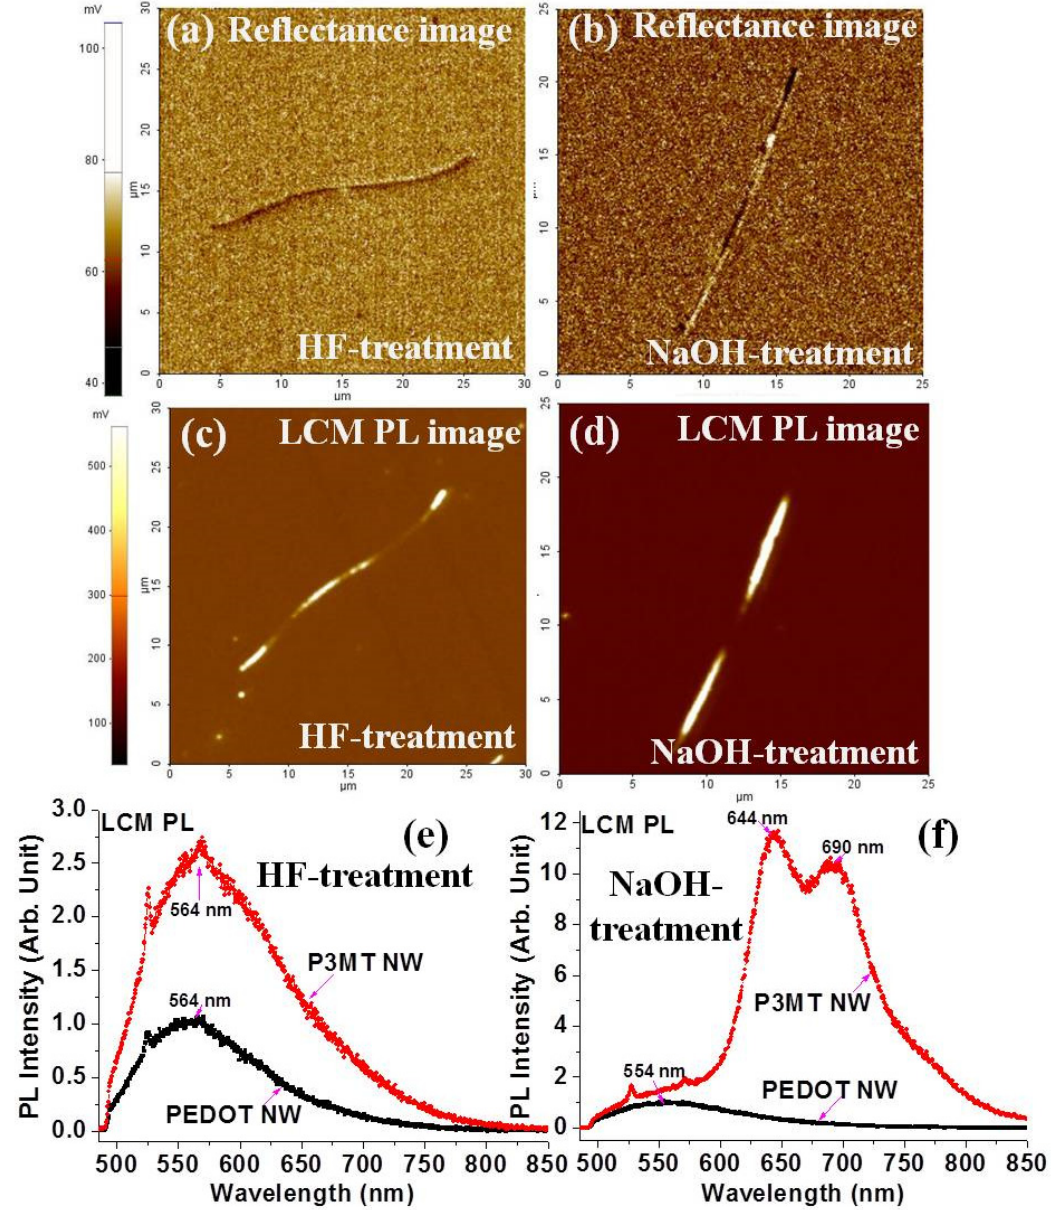
Figure 3. Reflectance images of: ( a ) HF-treated barcode NW; and ( b ) NaOH-treated barcode NW. Two-dimensional LCM PL images of: ( c ) HF-treated barcode NW; and ( d ) NaOH-treated barcode NW. LCM PL spectra of: ( e ) HF-treated barcode NW; and ( f ) NaOH-treated barcode NW.